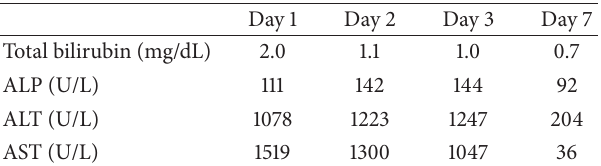
Table 1: Trend of